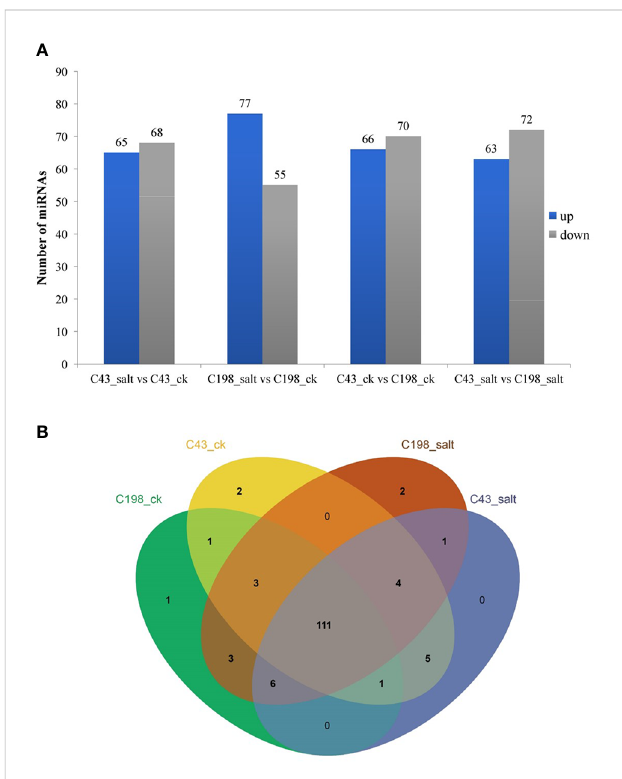
FIGURE 5 (A) Bar plot of differentially expressed miRNAs and their expression level. (B) Venn diagram showing miRNA sharing in four bermudagrass libraries with contrasting salt tolerance